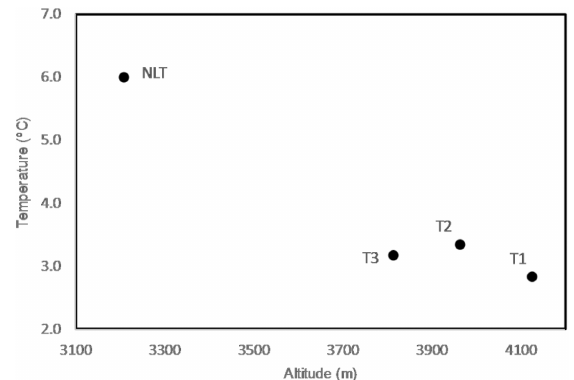
Figure 8. Mean annual ground surface temperatures versus altitude for the four monitored sites in the Djebel Toubkal